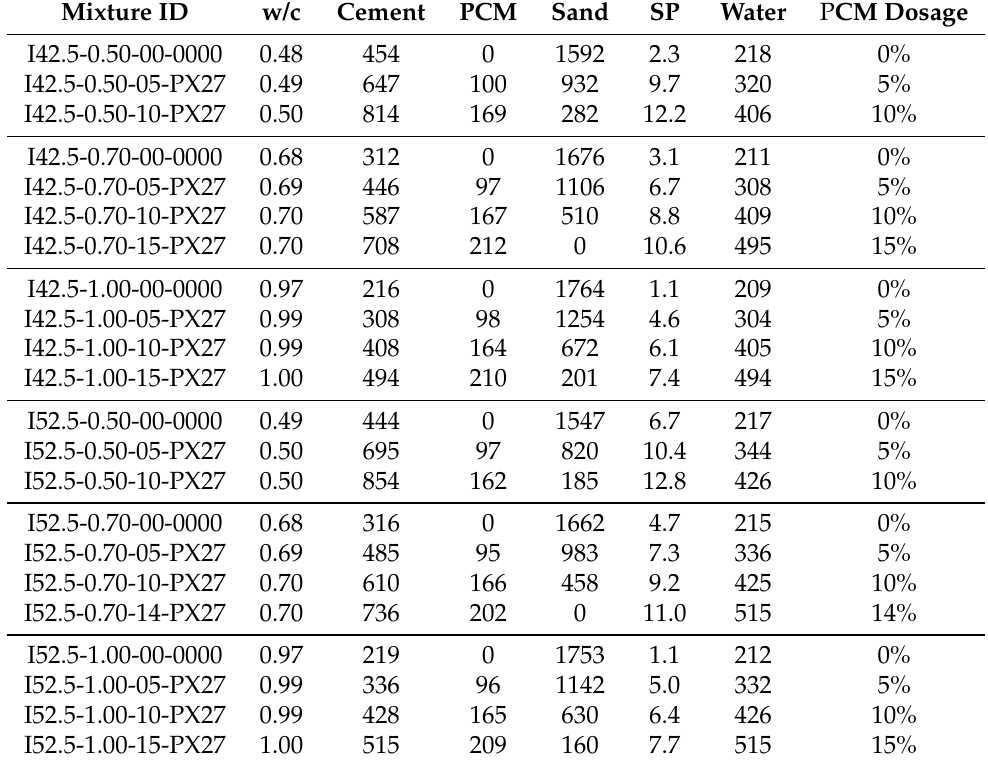
Table 6. Mortar mixtures compositions expressed as (kg/m 3 ).